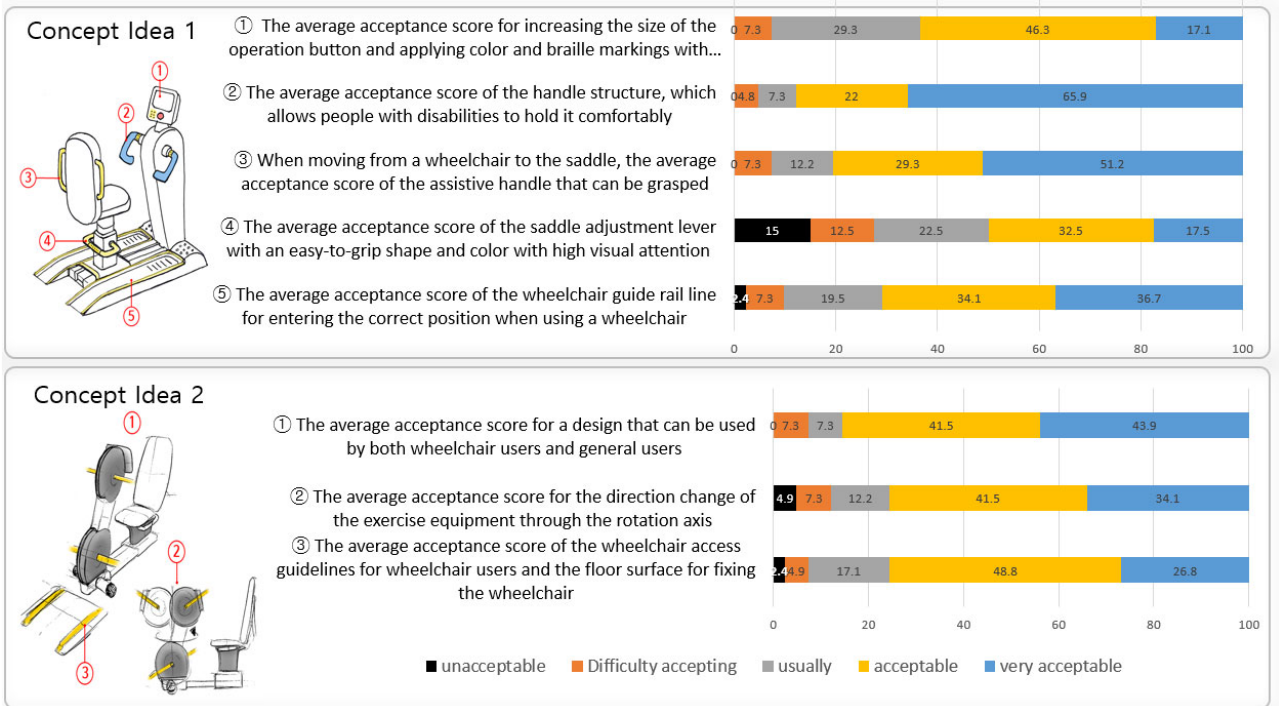
Figure 7. Evaluation result of concept idea acceptance of the treadmill with UD applied .